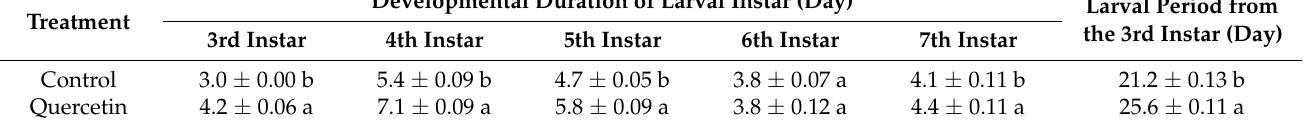
Table 1. The effect of 0.50% quercetin on the developmental duration of third-instar Hyphantria cunea